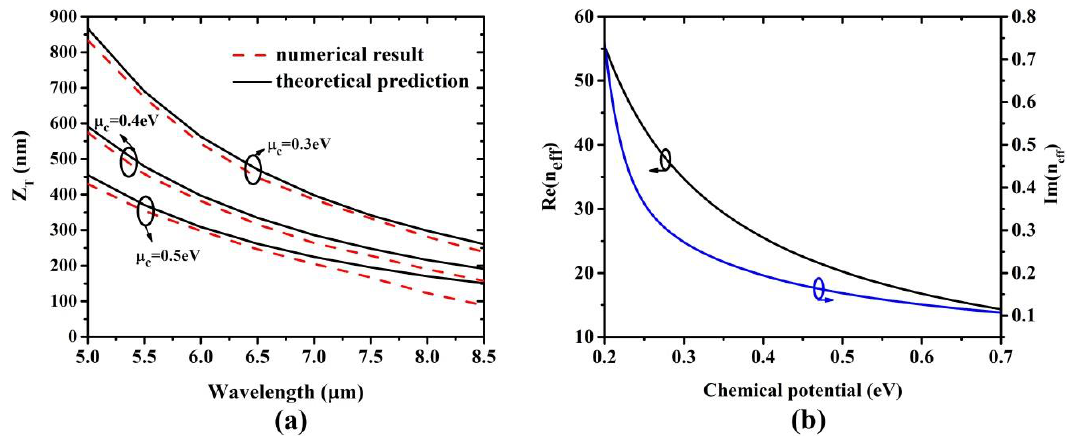
Figure 4. ( a ) Talbot distance varies with chemical potential of graphene and incident wavelength. ( b ) The imaginary part and the real part of the effective refractive index of graphene supported plasmon as a function of the chemical potential from 0.2 to 0.7 eV, where the wavelength is 7μm.